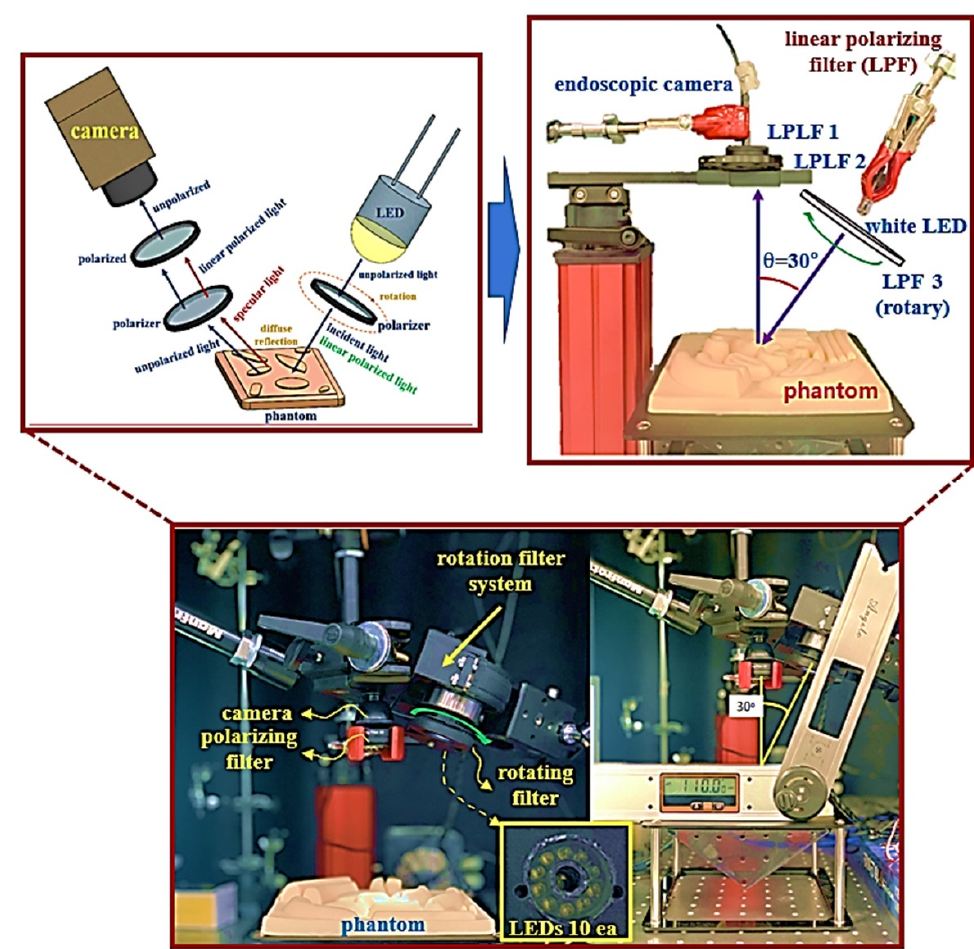
Figure 8. Experimental setup configuration.